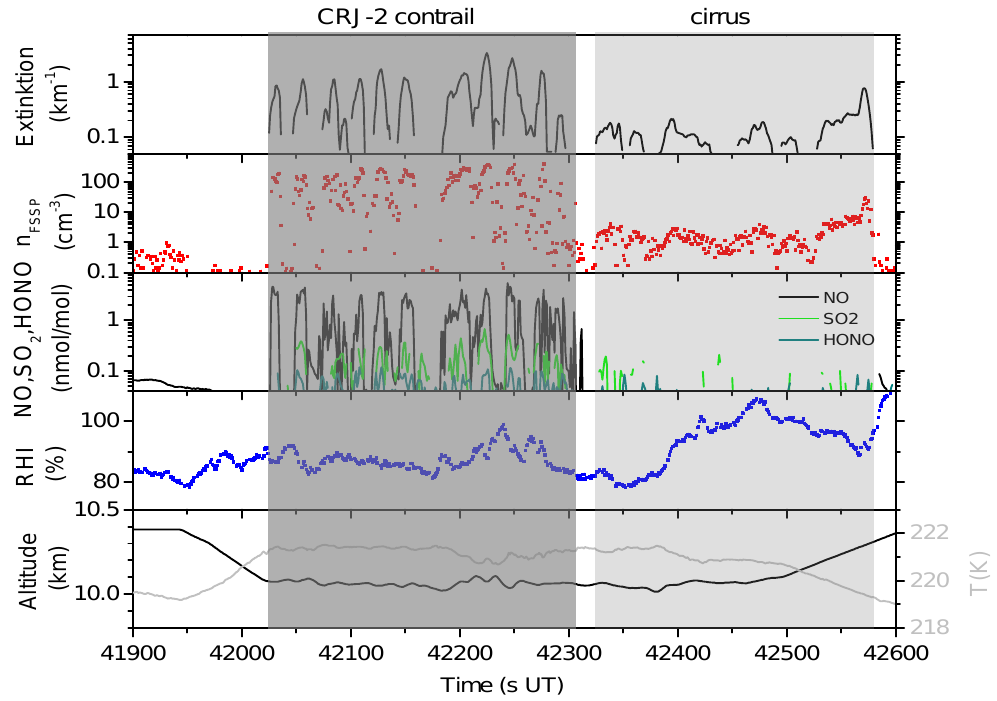
Fig. 9. Observations in the contrail from a CRJ-2 on 19 November 2008 above Germany. The flight altitude, temperature, RH I , and trace gas mixing ratios of NO, SO 2 and HONO as well as particle number density detected with the FSSP and extinction for particles larger than 3µm are shown. The contrail (cirrus) sequence is marked in dark (light)